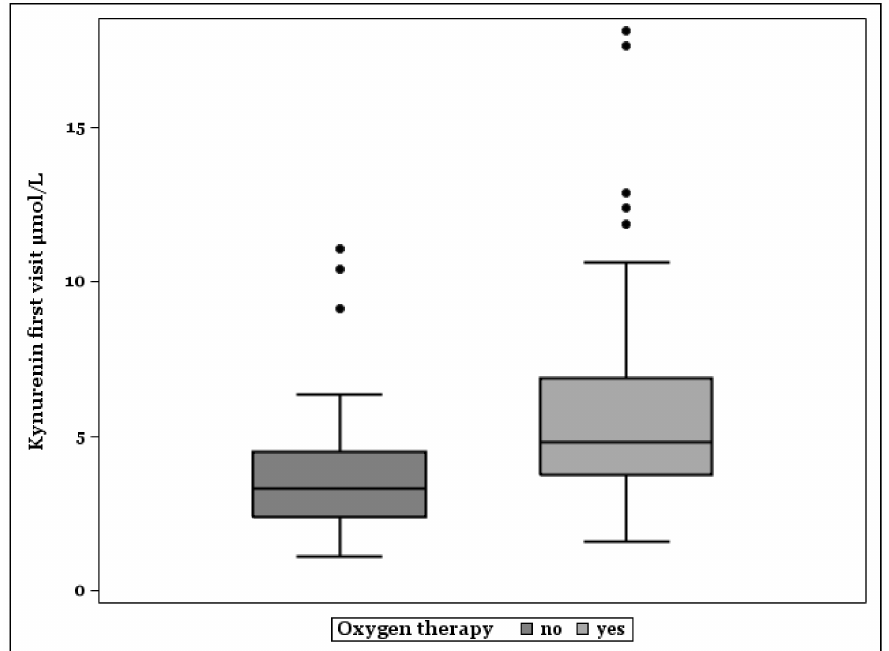
Figure 3. Box plots of kynurenine plasma levels in patients without, and with need of oxygen